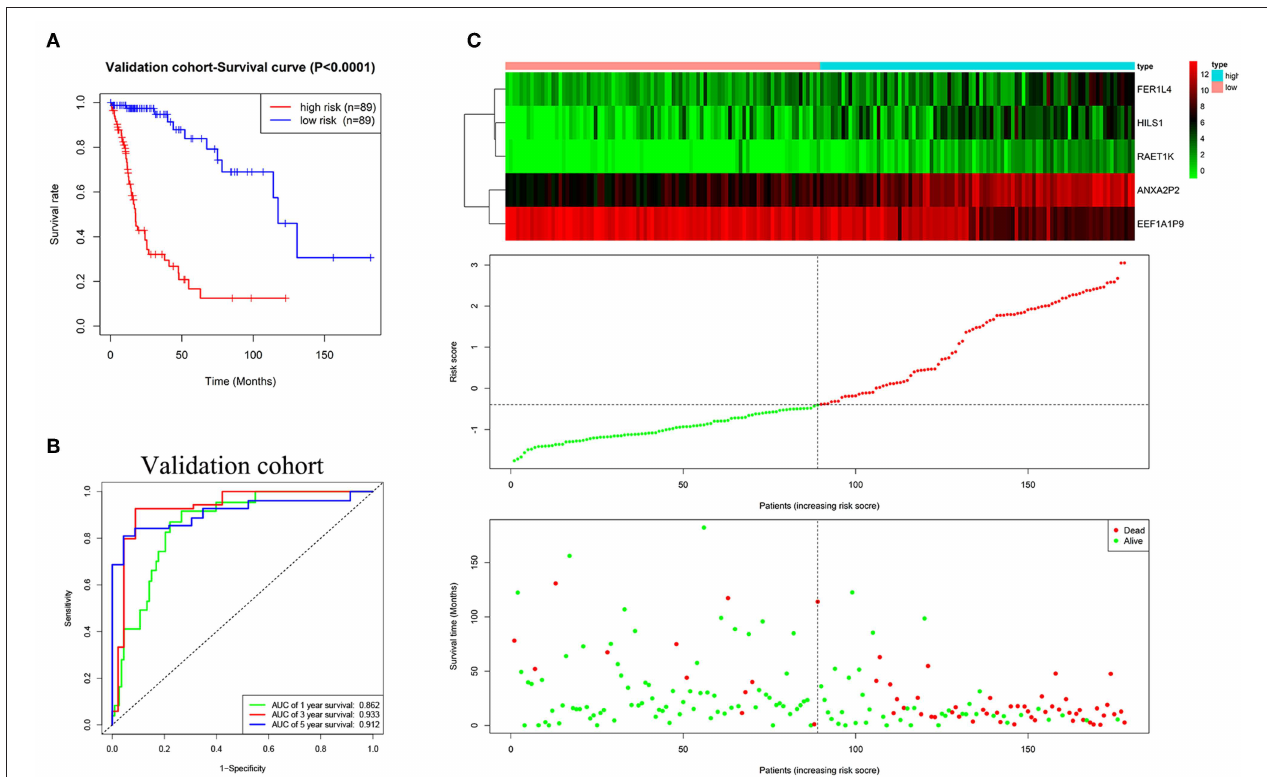
FIGURE 4 | Evaluating the efficacy of the five pseudogenes risk signature in the validation cohort. (A) Survival curves for high-risk and low-risk groups classified by the risk signature in the validation cohort. (B) ROC curves for the 1-, 3-, and 5-year survival according to the five-pseudogene risk signature in the validation cohort. (C) Glioma expression profiles of the five pseudogenes, risk score distributions and patient survival in the validation cohort.